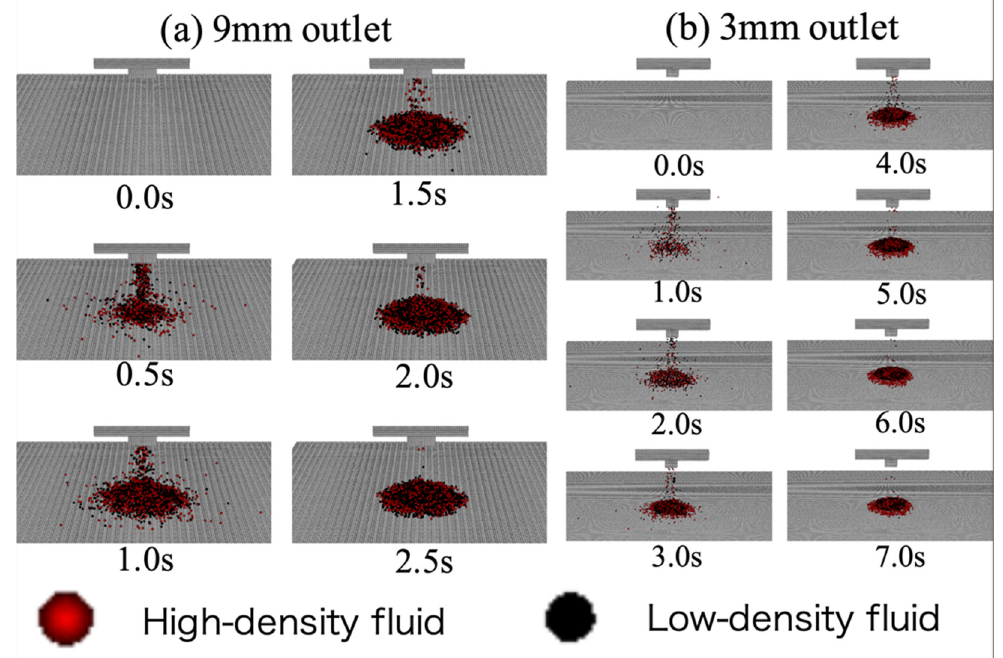
Figure 10. Snapshots of the spreading behaviour with different outlet in the case of the density stratification ( a ) 9 mm outlet, ( b ) 3 mm outlet.